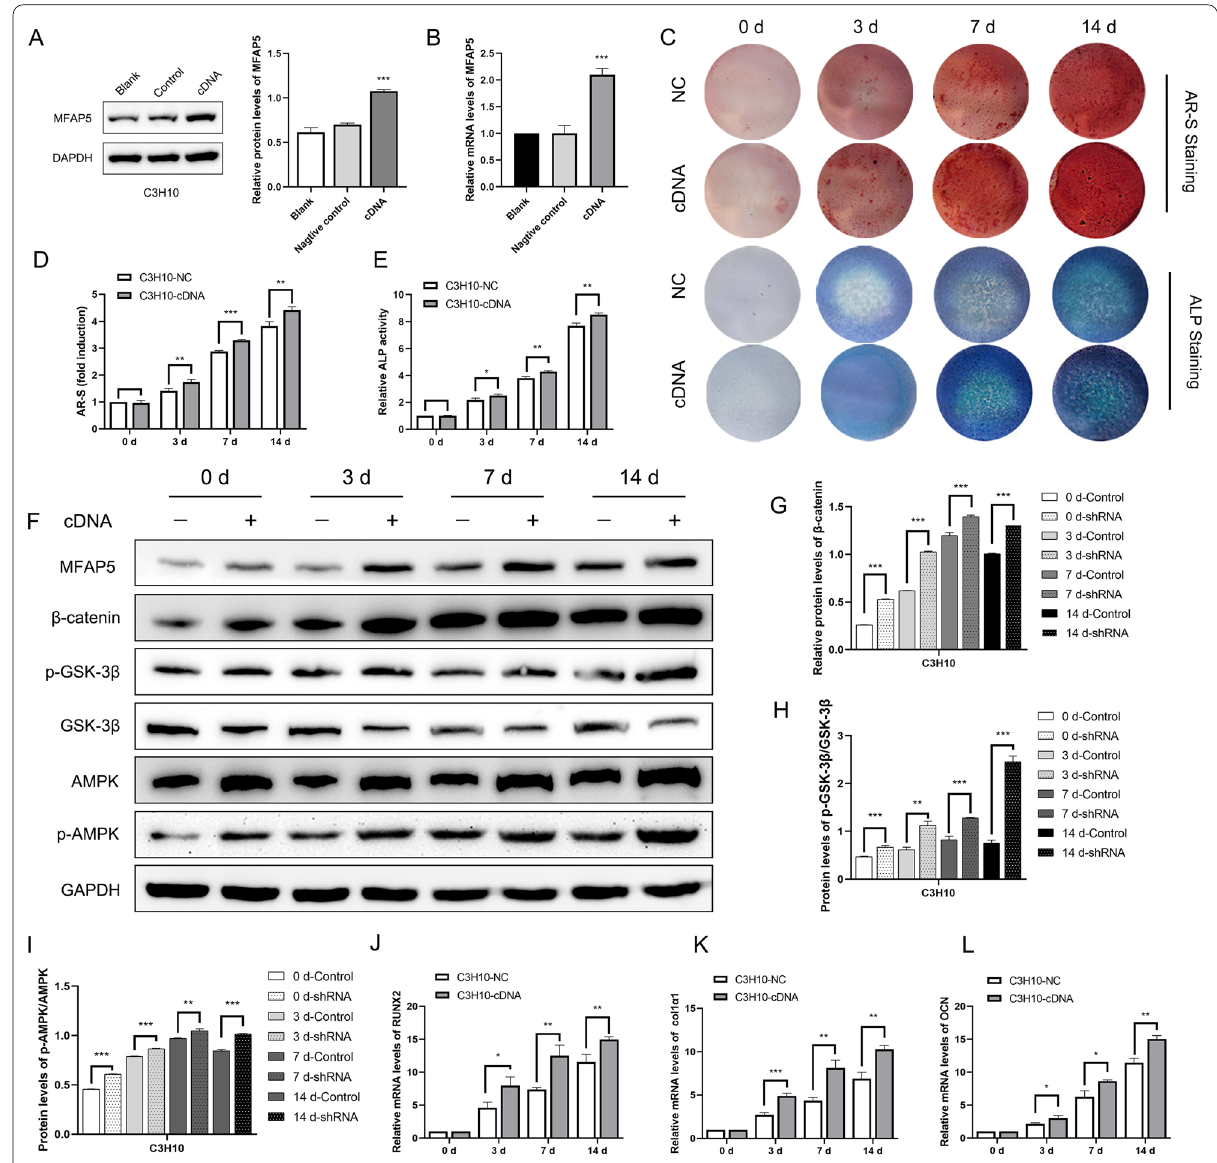
Fig. 4 MFAP5 overexpression promoted osteogenesis, which was mediated by the Wnt/β-catenin and AMPK signaling pathways. A , B C3H10 cells overexpressed MFAP5 in protein and mRNA. C The C3H10-cDNA group had more calcified nodules and higher ALP expression than the other groups during osteogenic induction. D , E The ALP activity level and AR-S staining revealed that the osteogenic capacity of the two groups differed. F The MFAP5, β-catenin, p-GSK-3β, GSK-3β, AMPK, and p-AMPK expression levels indicated that the Wnt/β-catenin and AMPK signaling pathways were more highly activated in the C3H10-cDNA group. G – I Relative protein levels of β-catenin, p-GSK-3β/ GSK-3β and p-AMPK/AMPK. J – L The levels of the classical osteogenic biomarkers Runx2, Col1α1, and OCN in the C3H10-NC and C3H10-cDNA groups. Values are expressed as means standard deviations (*P < 0.05, **P < 0.01, ***P < ±